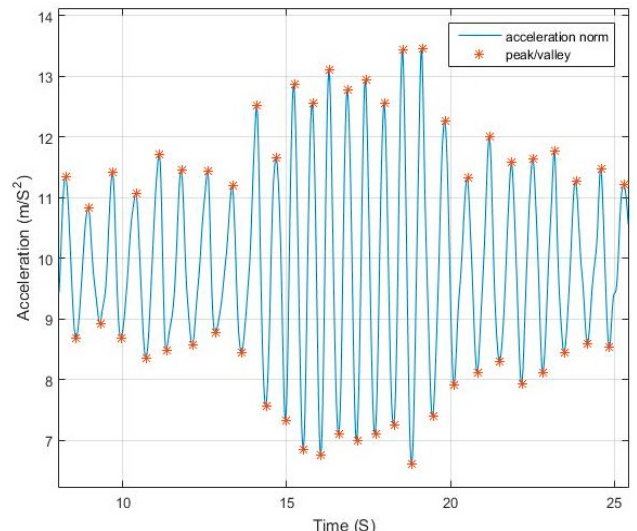
Figure 1. Walking sinusoidal pattern.